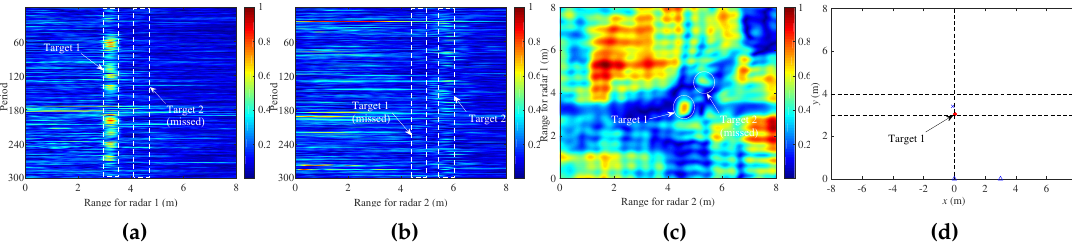
Figure 14. Results of Experiment 2.3 with 3 m interval between two radars: ( a ) range profile plane for Radar 1; ( b ) range profile plane for Radar 2; ( c ) cross-correlation image; and ( d ) localization